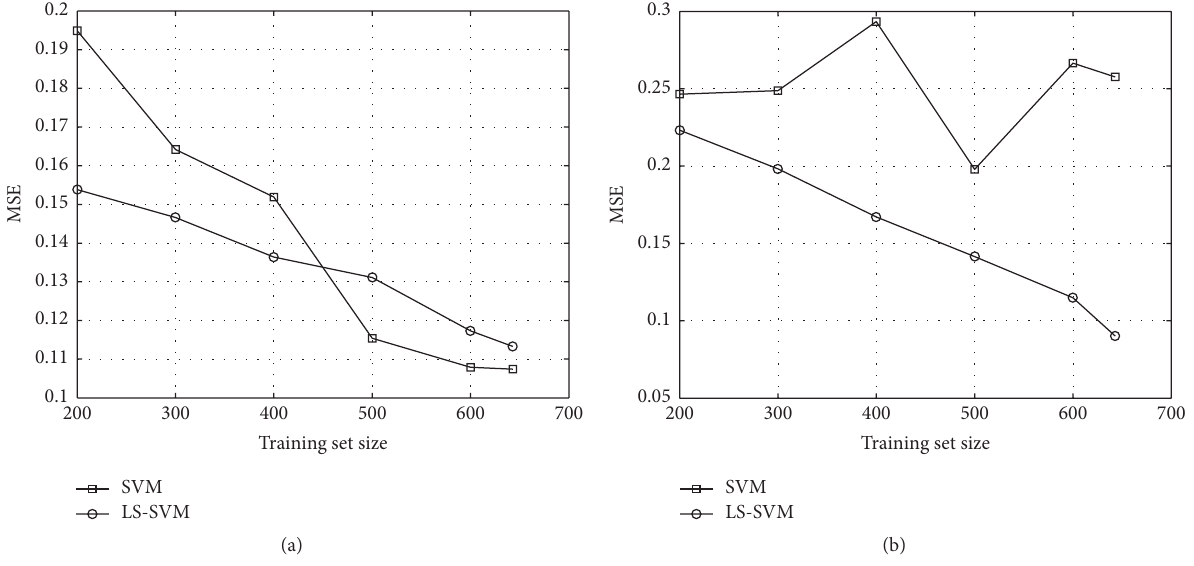
Figure 7: Impact of the number of training samples on MSE for (a) horizon and (b) depth of the target center.